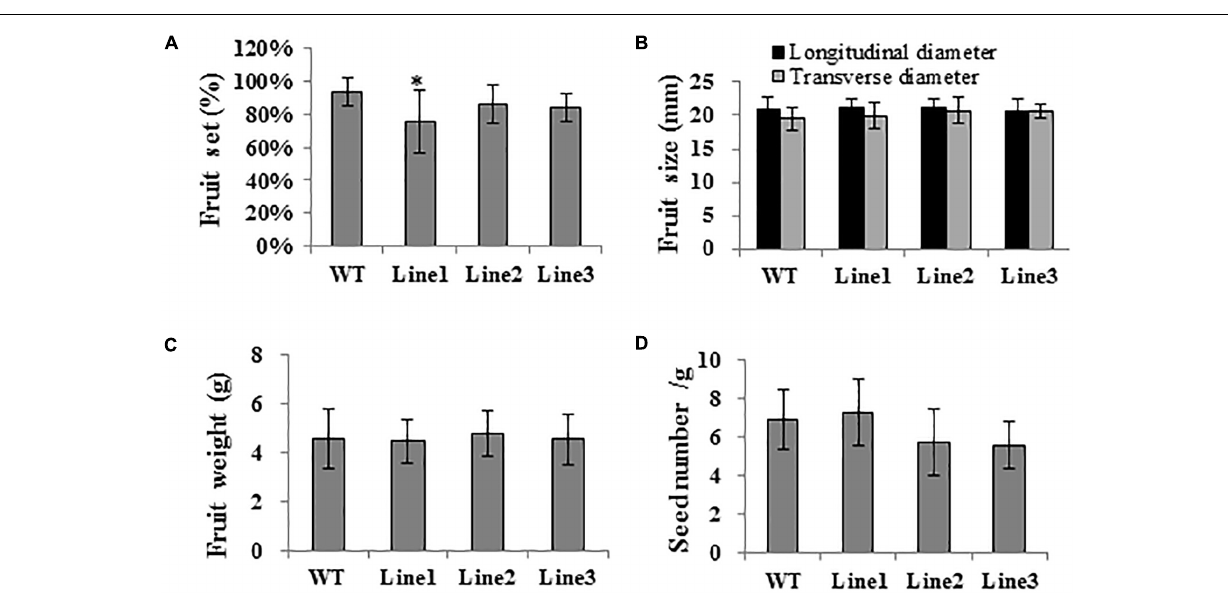
FIGURE 3 | (A-D) Phenotyping of SlTPL1-RNAi tomato plants. Characterization of fruit set, fruit size, fruit weight, and seed number in SlTPL1-RNAi plants. T -test was used for statistical analyses of comparison between the WT and each line, * P <